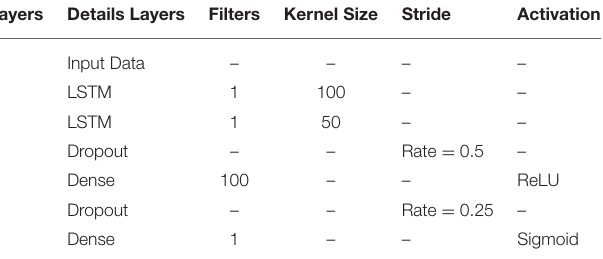
TABLE 5 | The details of the second proposed LSTM model.